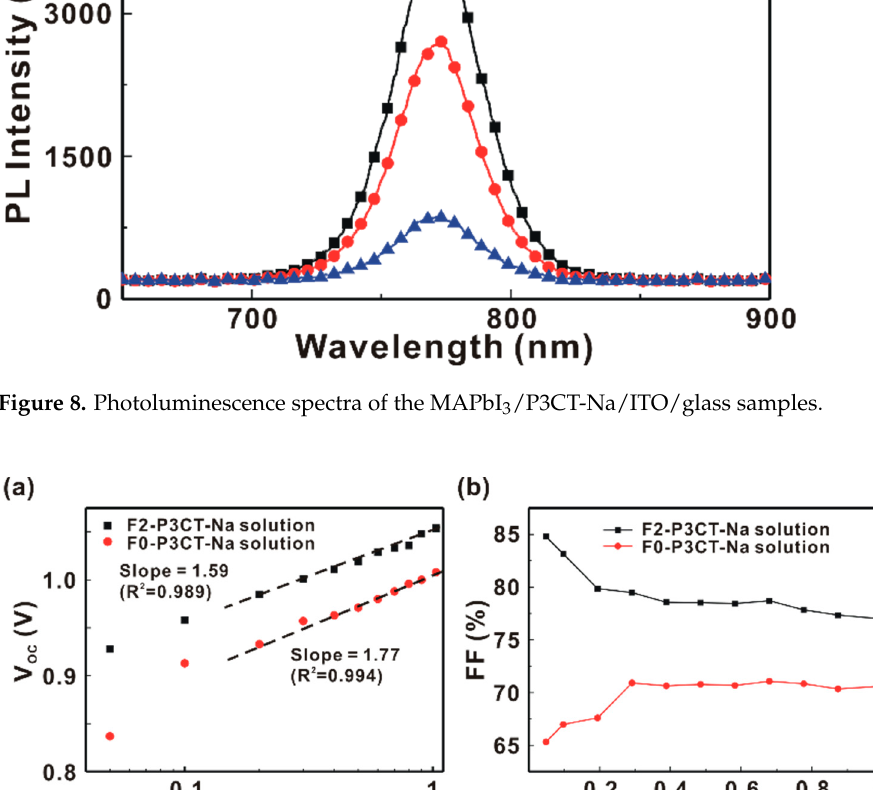
Figure 11. ( a ) Wavelength-dependent fill factor and ( b ) wavelength-dependent power conversion efficiency (PCE) of the P3CT-Na based MAPbI 3 solar cells under a low light intensity of 4 mW. Figure 12. Raman scattering spectra from the MAPbI 3 /P3CT-Na interface under a green laser exci- tation with an objective lens (50×). 4. Conclusions In summary, the averaged power conversion efficiency (PCE) of the P3CT-Na based MAPbI 3 solar cells can be largely increased from 11.72 to 18.92% by improving the con- tact quality at the MAPbI 3 /P3CT-Na interface with a double-filtering process for the